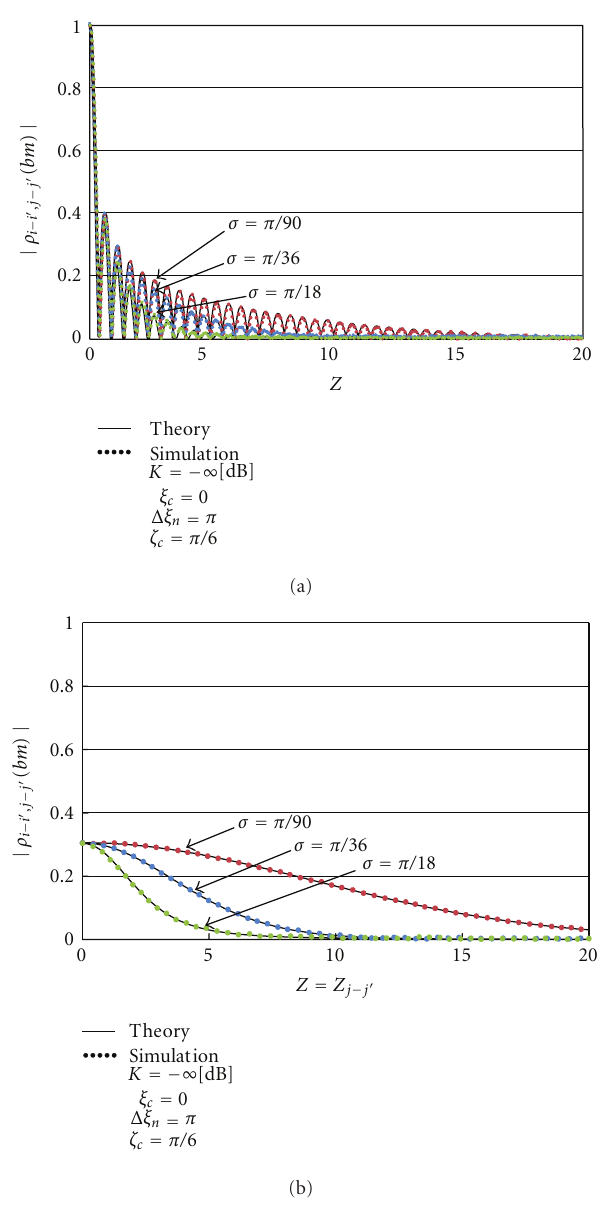
with both-side uniform distribution with ξ c = 0 and π in NLOS; the only di ff erence was the antenna Δ ξ n = radius λ mi = λ bj = 0 . 25 and 0.07 to make low and high correlations by (11) or the theoretical correlation between one MIMO antenna element and the next one | ρ i − i +1 ( m ) | = b ) | = 0 . 45 and 0.95, respectively. Here, ρ in Figure 7 | ρ j − j +1 ( means | ρ i − j , i (cid:2) − j (cid:2) ( bm ) | from (10) . Moreover, Figure 7(c) was